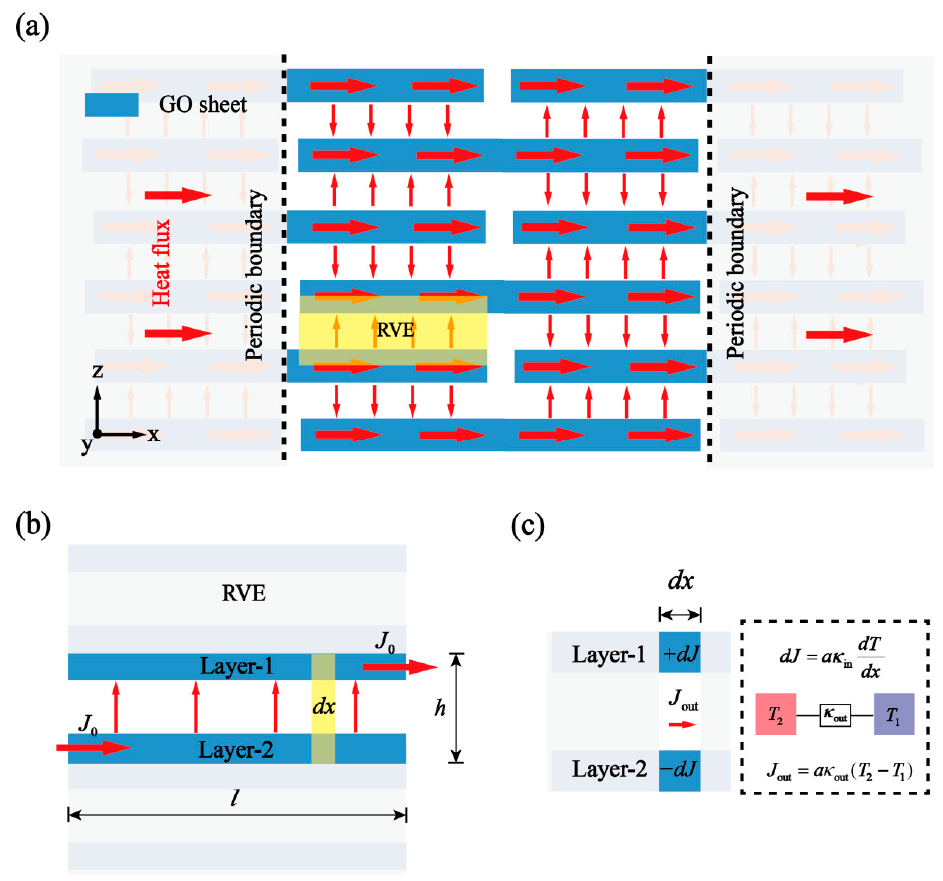
Figure 2. A schematic illustration of the heat-flow model for GO films. ( a ) The overall platelet structure and representative volume element (RVE). ( b ) The heat flow transfer in RVE. The physical parameters and boundary conditions are used in the analytical model. ( c ) The equilibrium relationship between in-plane and out-of-plane heat flow in the infinitesimal